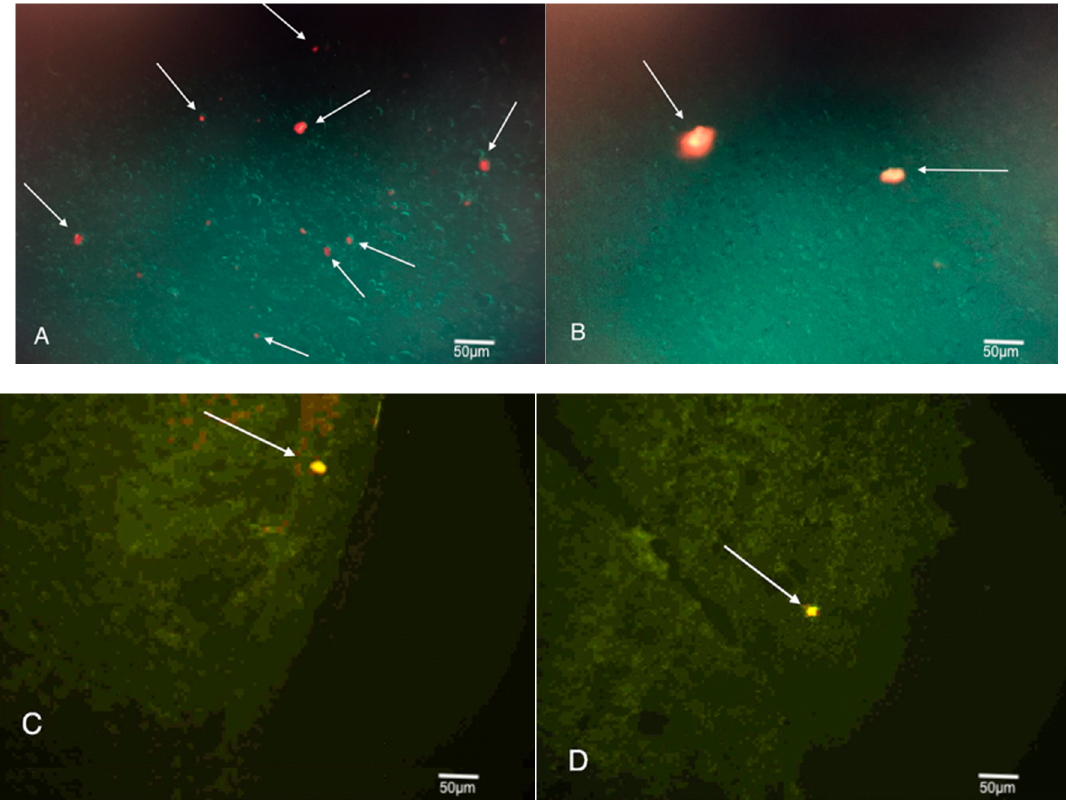
Figure 4. Images A and B were taken at 4x magnification and show SVF Q-Dot labeled cells within the left frontal cortex of Group 1 animals. Images C and D were taken at 4x magnification and show SVF Q-Dot labeled cells within the left frontal cortex of Group 2 animals.